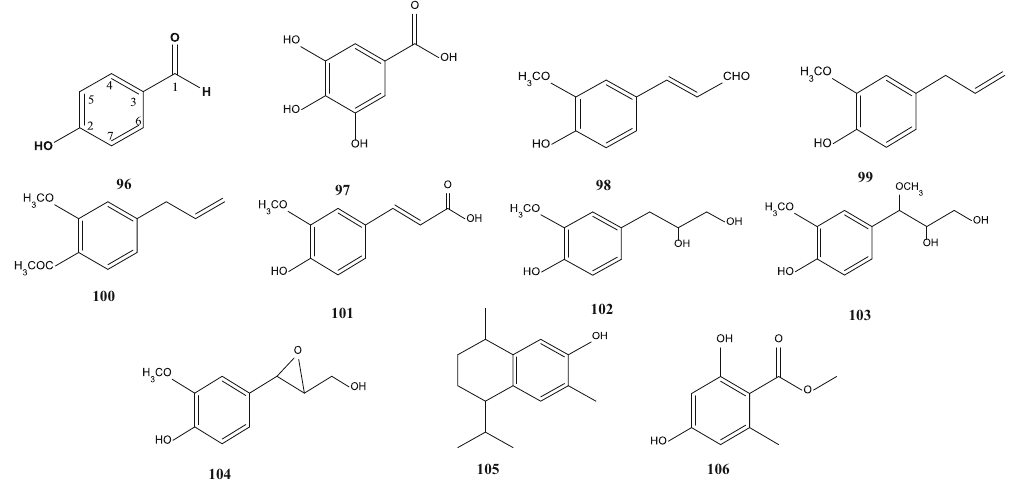
Figure 8: Phenyls of S. aqueum , S. samarangense and S. aromaticum .